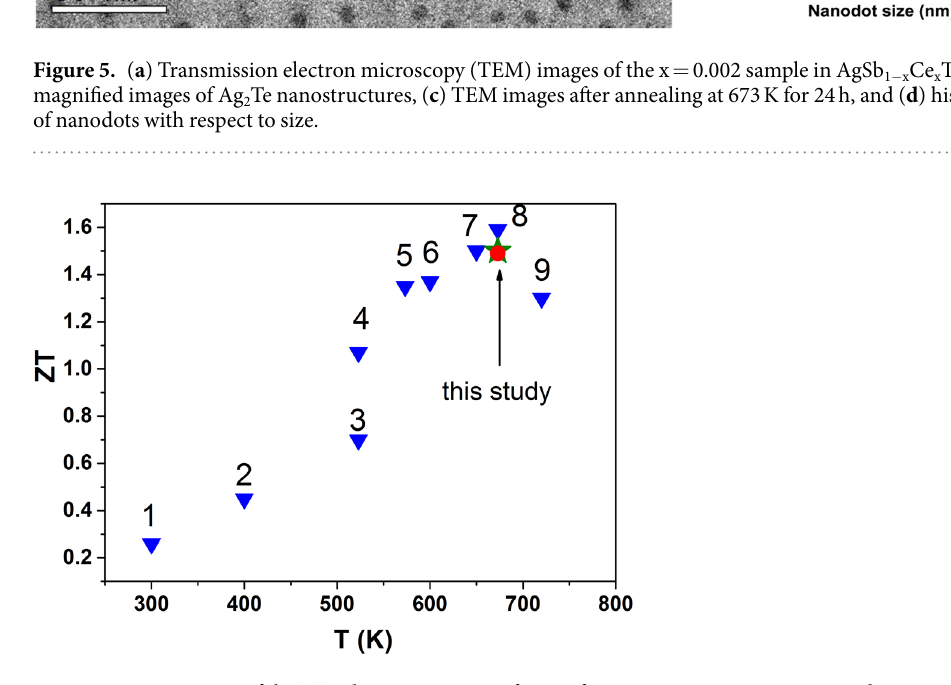
Figure 6. Comparison of the ZT values:Data 1~9 are from ref. 13, 40, 41, 42, 20, 17, 19, 16 and 43,